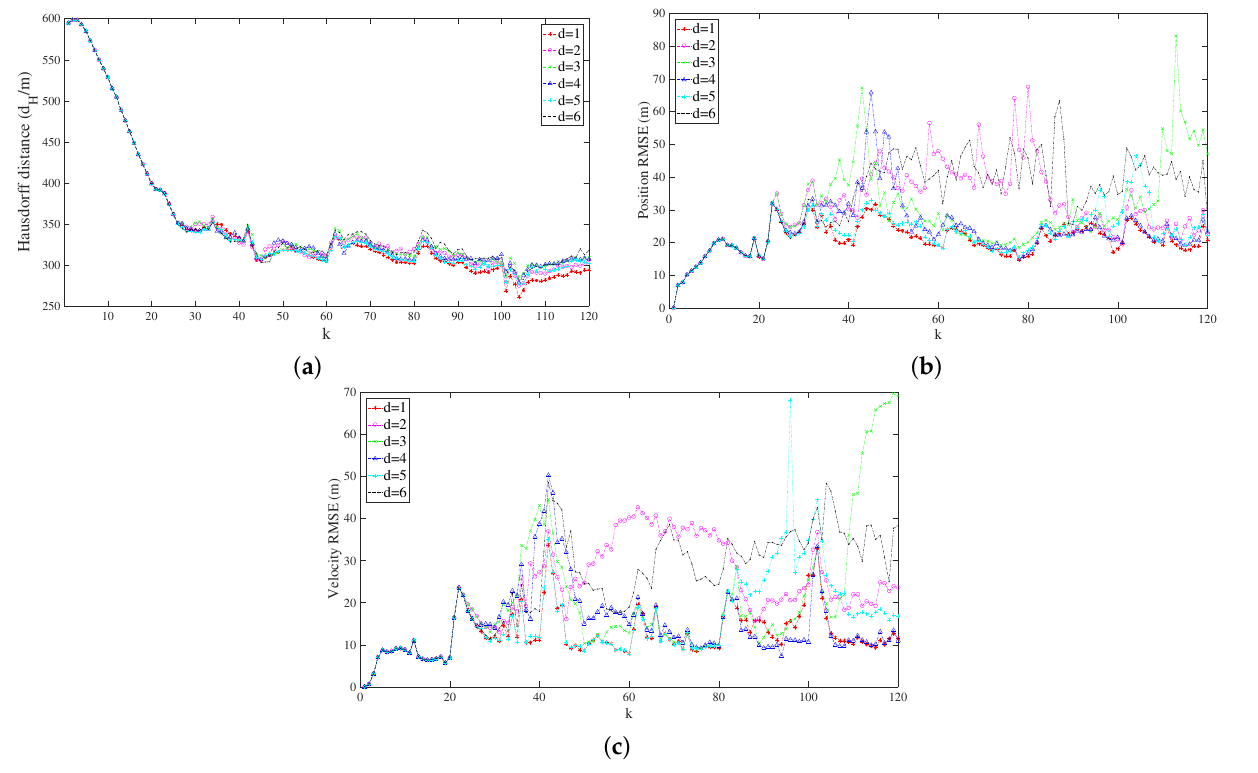
Figure 7. The correction ability with different values of d . ( a ) Hausdorff distance. ( b ) RMSE of position. ( c ) RMSE of